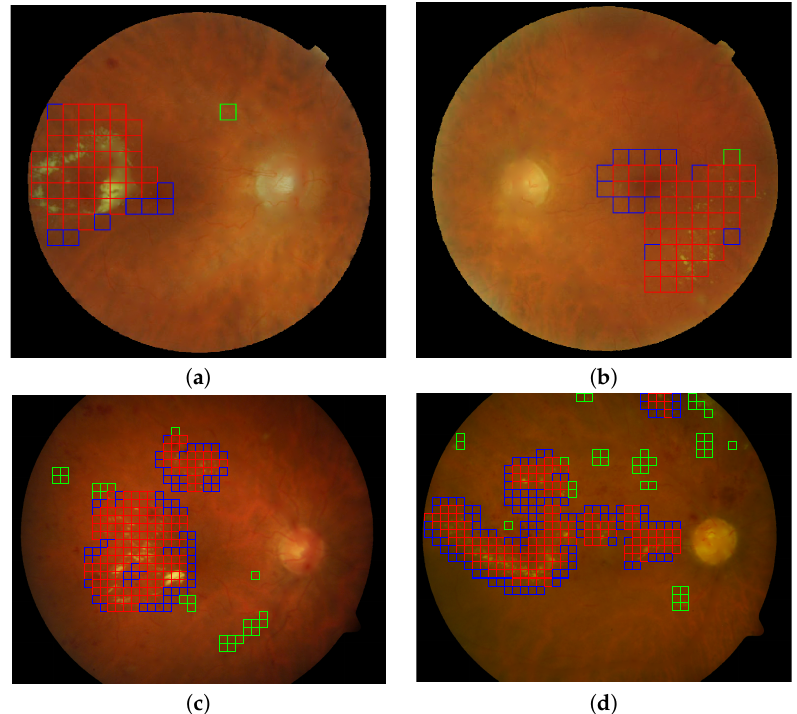
Figure 11. Automatic lesion detection in four retinal images using the best configuration of feature vector and gaussian processes for classification. ( a , b ) Two representative images (DS000U30.jpg and DS0009NU.jpg) from the E-OPHTHA exudates database and ( c , d ) two representative image (image014.png and image016.png) from DIARETDB1 database. Red squares indicate the true positives, green squares the false positives and the blue squares reveal the false negative detections.